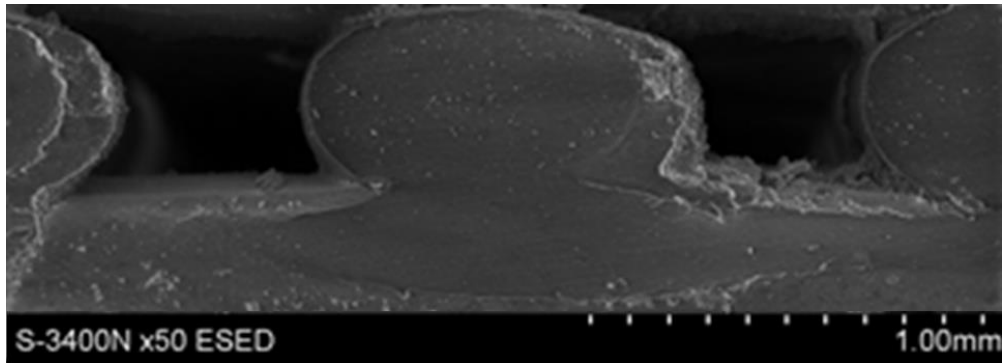
Figure 5. Bonding between path layers in the 3D printout printed from the LDPE30 composite.